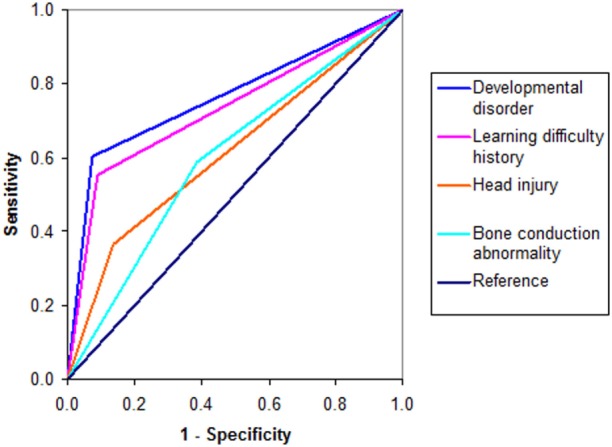
ROC curves for risk factors.